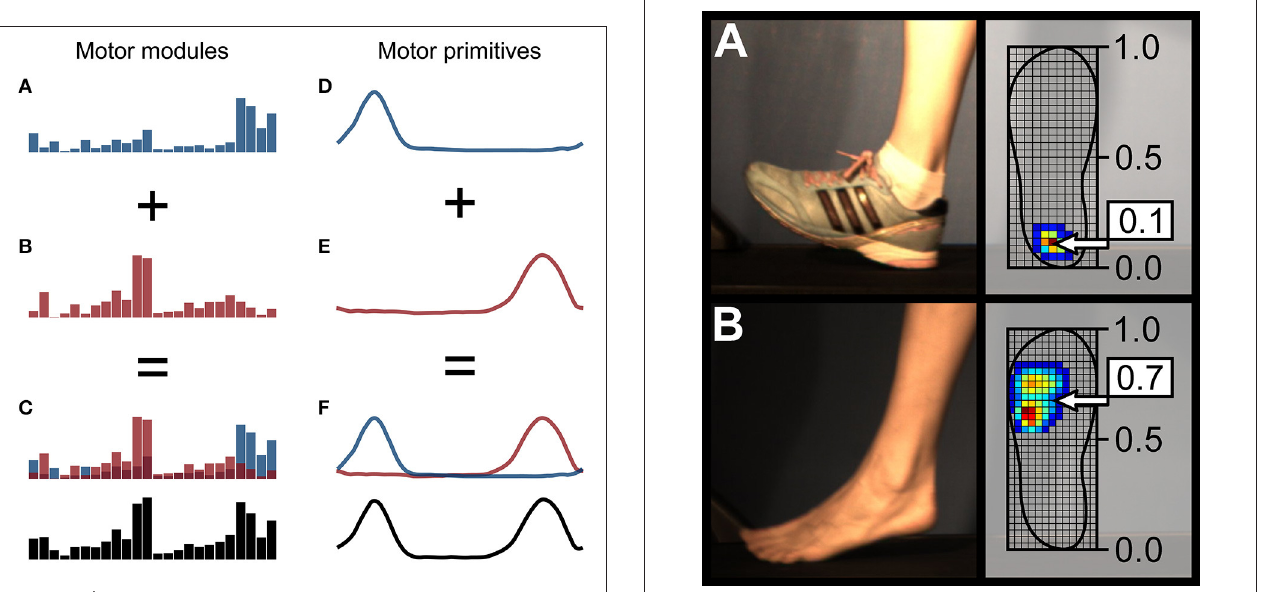
FIGURE 2 | Sagittal view of a typical rearfoot (A) and forefoot (B) strike patterns during shod and barefoot running, respectively. The strike index values extracted from plantar pressure distribution for these two representative cases are presented as